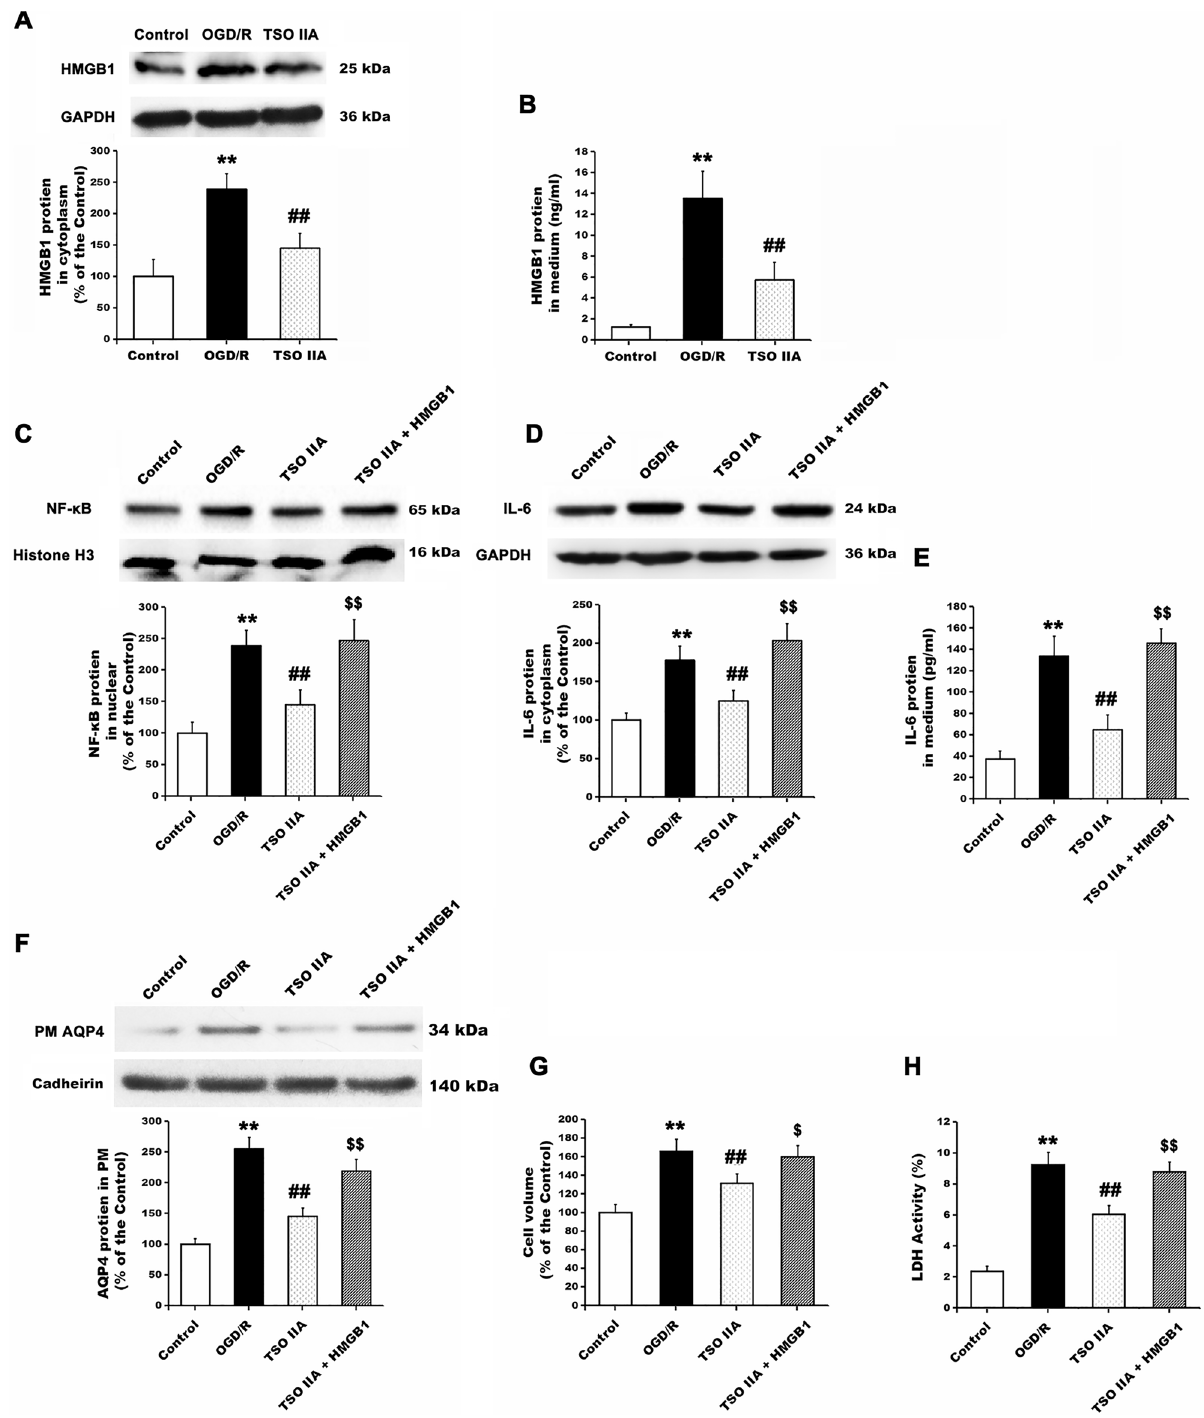
Figure 3. TSO IIA reduced cell swelling through inhibition of the HMGB1-activated inflammatory axis. ( A and B ) HMGB1 expression in the cytoplasm and culture medium after OGD/R, detected by Western blot and ELISA analysis in untreated cells and cells treated with TSO IIA ( n = 5 independent cultures). ( C ) NF-κB protein accumulation in the nucleus in astrocytes in response to vehicle, TSO IIA, or both TSO IIA and rHMGB1 ( n = 5 independent cultures). ( D and E ) IL-6 protein expression in the cytoplasm and medium after OGD/R in cells in response to vehicle, TSO IIA, or both TSO IIA and rHMGB1 ( n = 5 independent cultures). ( F – H ) AQP4 clustering in the cytoplasm, cell volume, and LDH activity after OGD/R detected from cells in response to vehicle, TSO IIA, or both TSO IIA and rHMGB1 ( n = 5 independent cultures). (The data of the aforementioned test are expressed as mean ± SEM. One-way ANOVA resulted in P < 0.01, ** P < 0.01 versus control; ## P < 0.01 versus OGD/R; CM: plasma